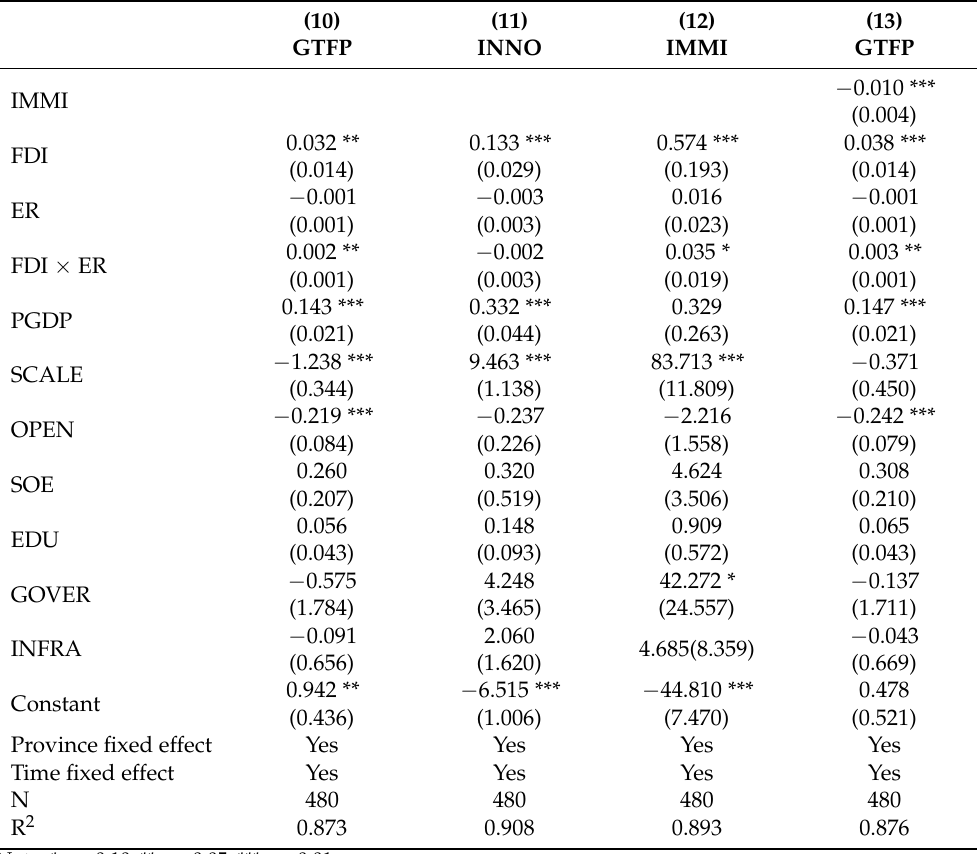
Table 6. The mediated moderating effect of environmental